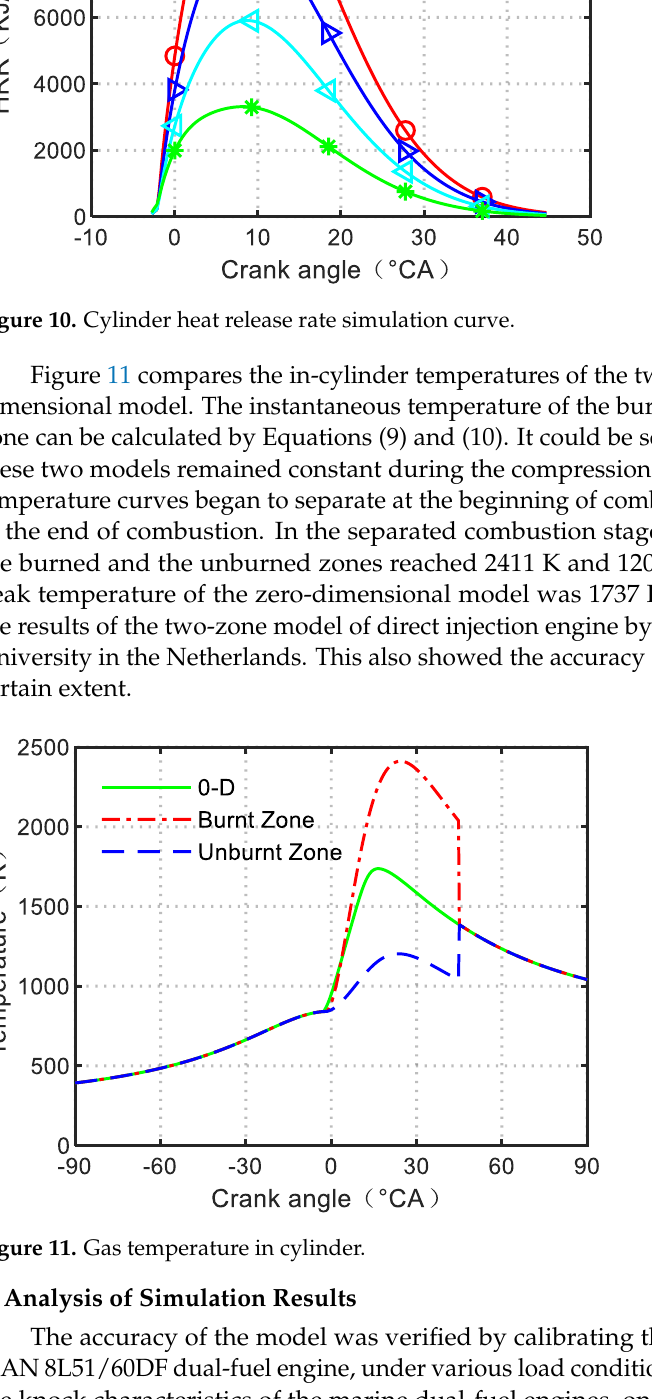
Figure 9. IMEP comparison between simulation and experiment.